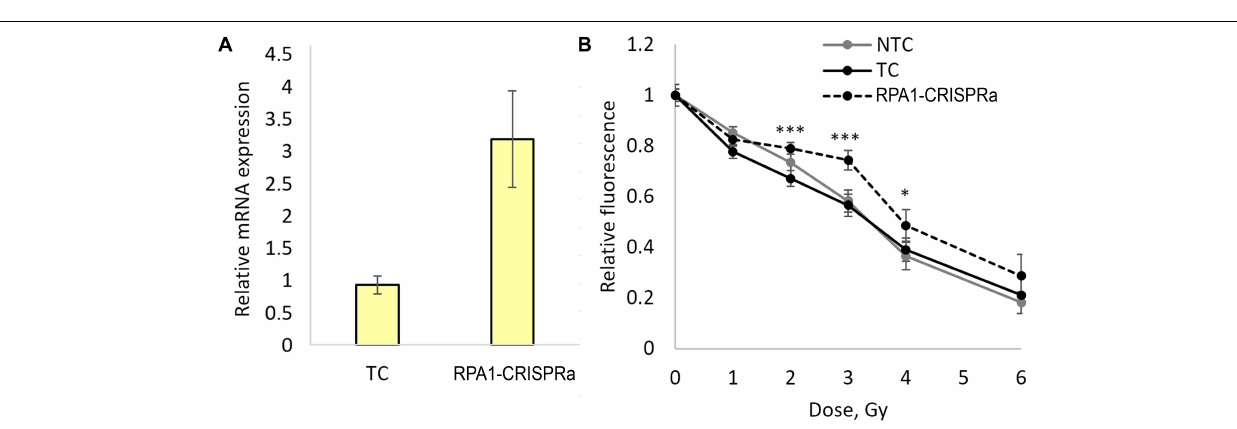
FIGURE 2 | Overexpression of the RPA1 gene detected using qRT-PCR (three samples analyzed per group) (A) and cell viability 72 h after exposure to γ -radiation at 1, 2, 3, 4, and 6 Gy analyzed using the FMCA (B) . Average values for 24 microcultures per data point are presented. Relative fluorescence is proportional to the number of live cells in the microculture. *, differences with the TC group are significant at p < 0.05, *** at p < 0.001 (Student’s t -test with the Bonferroni